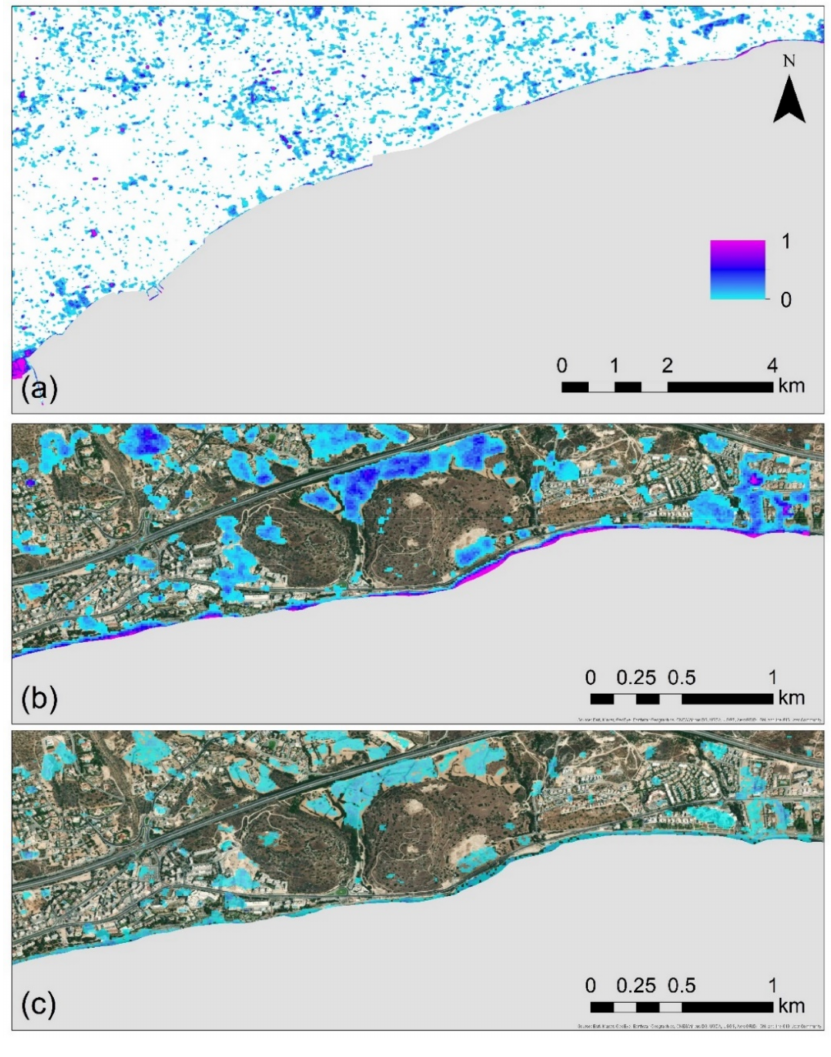
Figure 6. ( a ) Cumulative changes during the period 2015–2020 over the Limassol city, rescaled to 0–1, whereas zero (0) indicates areas with no changes and values close to one (1) area that have been changed in all Sentinel-1 images available in the Google Earth Engine; ( b ) a closer look at the cumulative changes during the period 2015–2020 around the Amathus archaeological site; and ( c ) the differences in relative changes between the year 2020 and 2015 around the Amathus archaeological